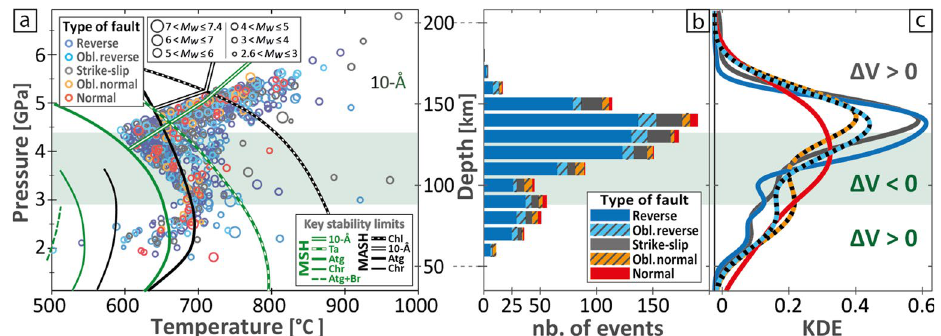
Figure 3. Mineral stability and distribution of seismicity in the Vrancea slab. ( a ) Pressure–temperature diagram showing conditions at hypocentres and the stability limits of key minerals 9 ; ( b ) depth distribution of the seismicity; ( c ) kernel density estimation (KDE) of the earthquake’s dataset for each focal mechanism. Oblique reverse faults and oblique normal faults respectively correspond to reverse and normal faults with substantial stricke-slip components. The green shade accounts for serpentine dehydration with a negative Clapeyron slope. Extended versions of a and b-c are presented in Figs. S3 and S4, respectively, showing the distribution for each class of focal mechanism. Abbreviations of minerals: Atg = antigorite; Br = brucite; Chr = chrysotile; Chl = chlorite; Ta = talc; 10-Å = 10-Å phase. Simplified chemical systems: MSH = MgO–SiO 2